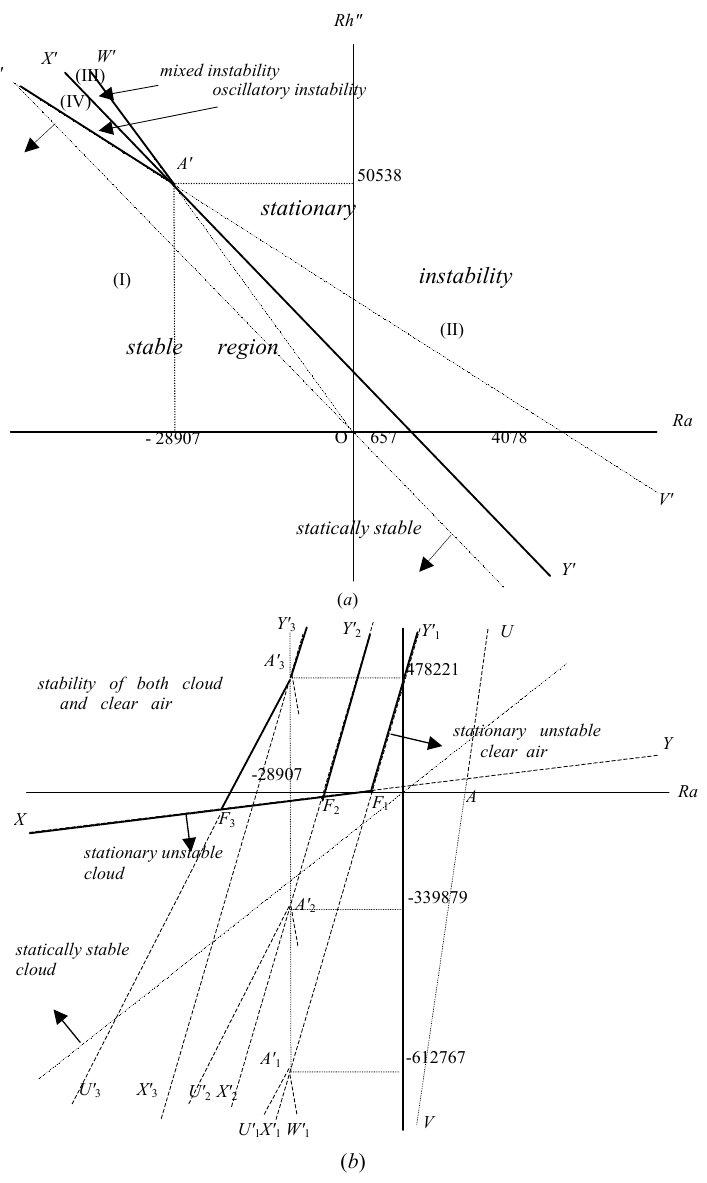
Fig. 6. Instability diagram in clear air: (a) in the (R a ,R h 00 ) plane; (b) in the (R a ,R h ) plane. The numerical values are the same as in Fig. 1. In Fig. 4a the stability parameter R 00 is defined with respect to the total moisture of the medium. Because the Schmidt number is very h near the Prandlt number, the double diffusion is weak (almost absent) in this figure, the oscillatory instability being confined in a very sharp angular sector U 0 A 0 W 0 . In Fig. 6b, the parameter R h = − R h 00 + 3 0 R a + P r R e 2 [ 3 0 − γ/(γ − 1 ) ] is used instead of R h 00 , in order to be able to match together stable and unstable regions of both saturated and unsaturated cases, as it occurs in the coupled instability of two layers of fluid. In the latter case, three values of R e are considered: (i) R e = 1 (stable region inside the angle XF 1 Y 0 1 ); (ii) R e = 150 (stable region inside the angle XF 2 Y 0 2 ); (iii) R e = 300 (stable region inside the sector XF 3 A 0 3 Y 0 3 ): in that case, the instability of the clear air may be oscillatory (threshold F 3 A 0 3